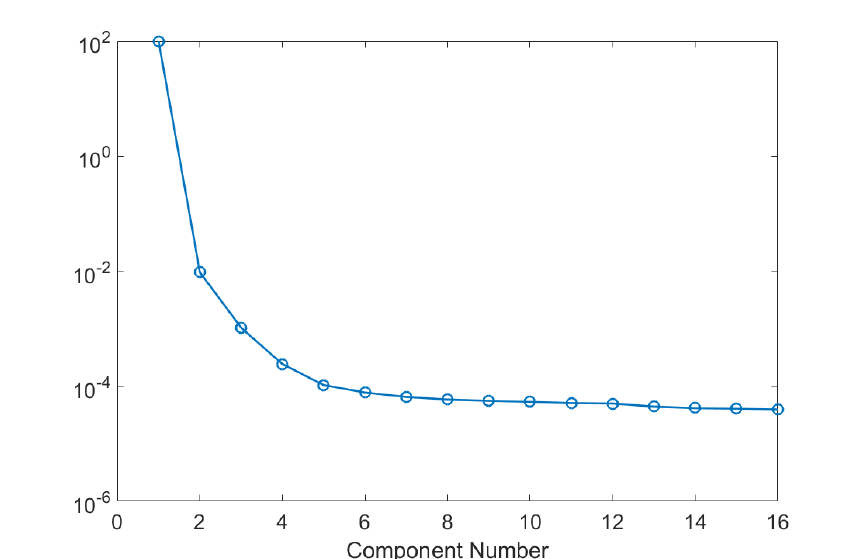
Figure A1. Variance distribution of eigenvalues obtained via PCA. It Four components make up the majority of variance, all subsequent can be considered as representing experimental noise.